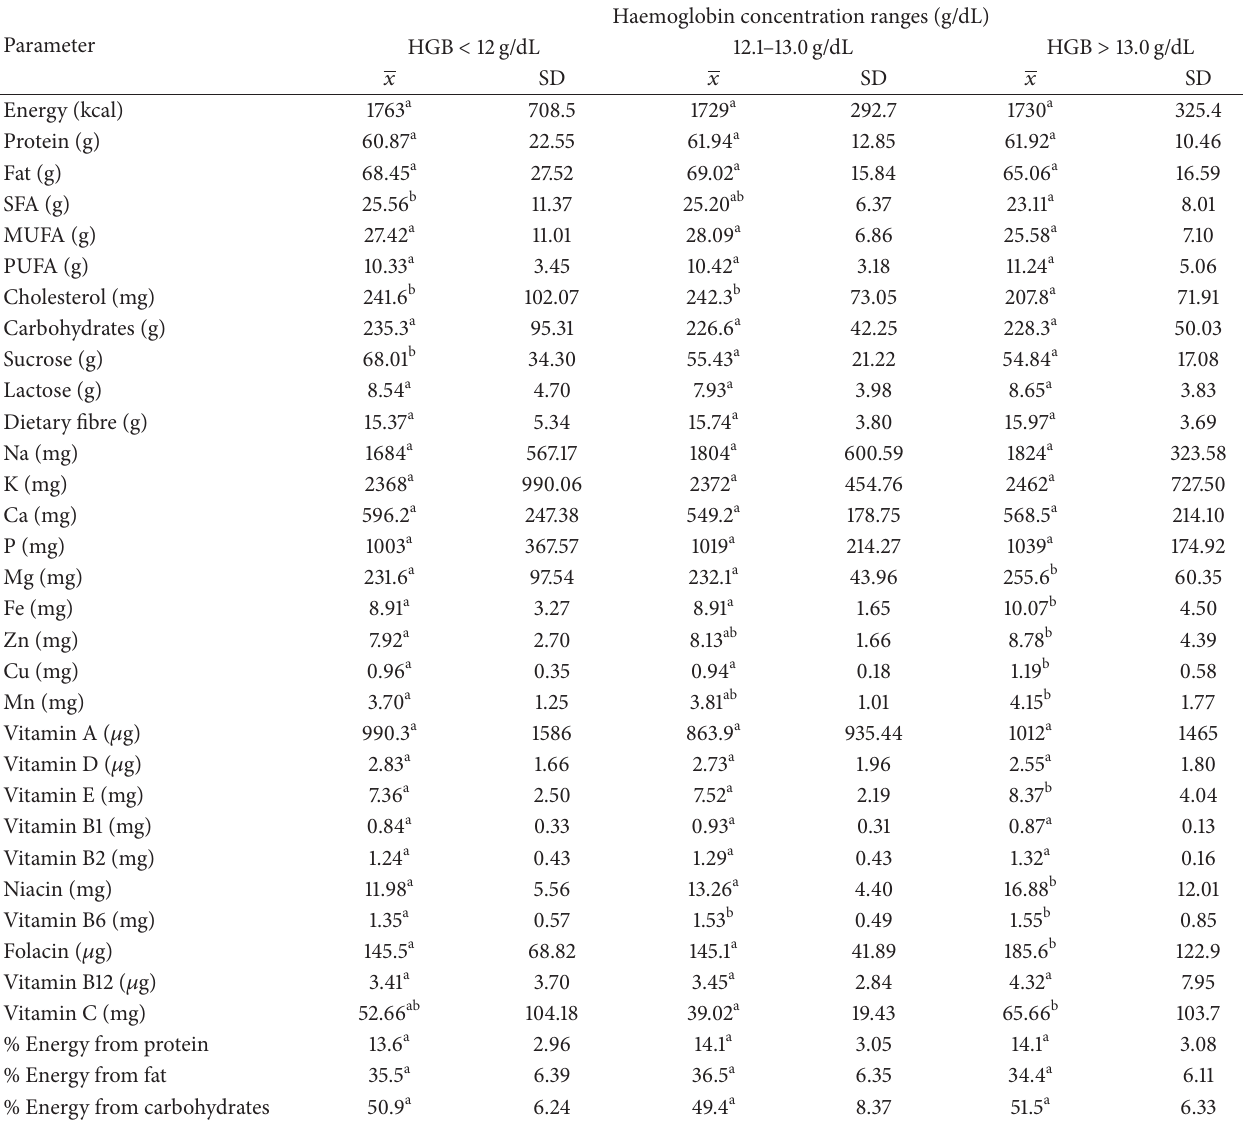
Table 2: Women’s DFR composition with respect to haemoglobin concentration in